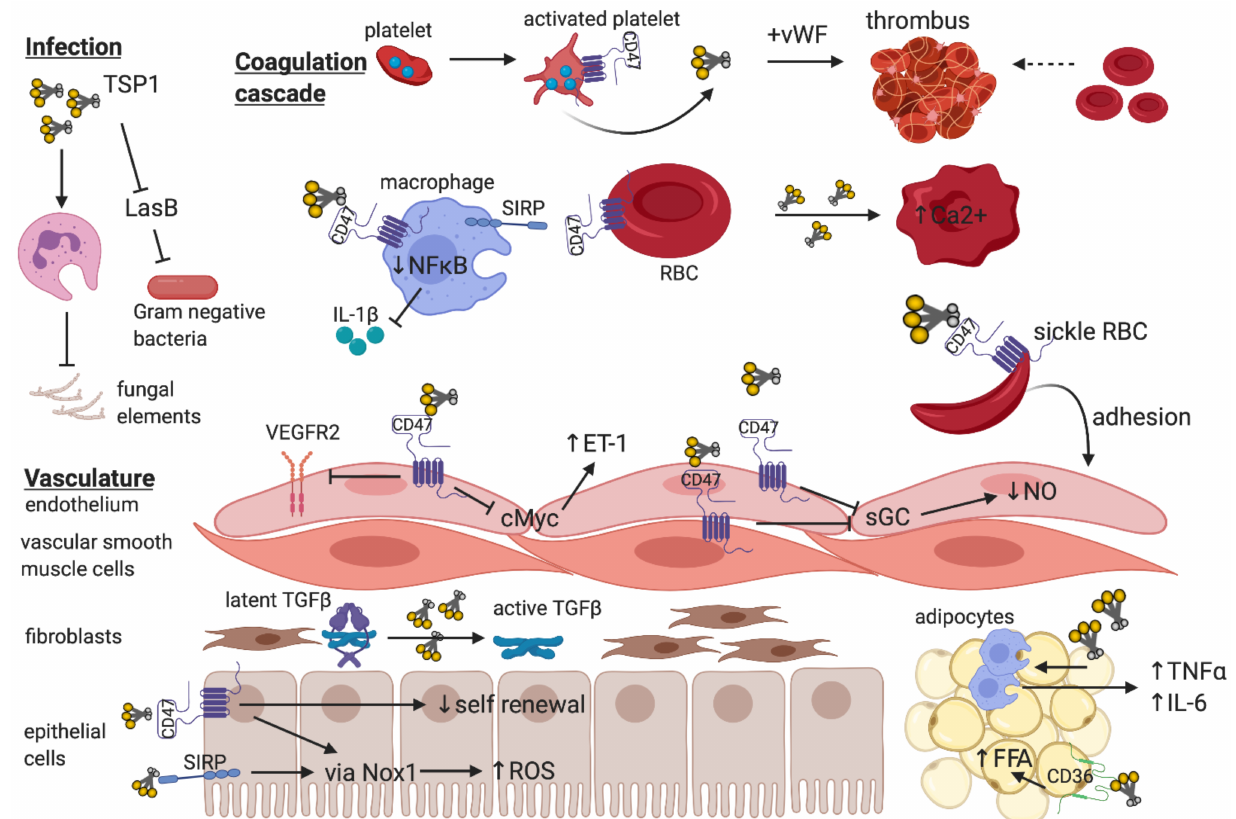
Figure 2. The breadth of TSP1 regulation of cellular function—The trimeric matricellular protein TSP1 is normally se- questered within platelet α -granules, but is released following platelet activation to promote thrombus formation at the site of vascular injury [70]. Within the circulation, TSP1 binds to CD47-expressing macrophages to limit NF κ B-based transcrip- tion and release of pro-inflammatory cytokines [107] and inhibits virulence factors that facilitate gram negative bacterial infections [33]. Paradoxically, TSP1 impedes leukocyte phagocytosis of fungal elements thereby promoting susceptibility to infection [31]. Signal inhibitory regulatory protein (SIRP)-bearing patrolling macrophages also provide recognition of “self” via CD47 expressed on red blood cells (RBC), which inhibits phagocytosis [108]. Exogenous TSP1 disrupts RBC shape and increases intracellular Ca 2+ [33]. Increased TSP1 released in the context of vaso-occlusive crises in sickle cell disease promote adhesion of CD47-expressing sickle RBC to endothelium [65]. Endothelial and vascular smooth muscle cells express CD47, and binding of TSP1 inhibits soluble guanylate cyclase (sGC) to reduce nitric oxide (NO) synthetic capacity [58] and limit vasorelaxation. Activated CD47 on endothelium inhibits VEGFR2 neo-angiogenic function [10] and downregulates